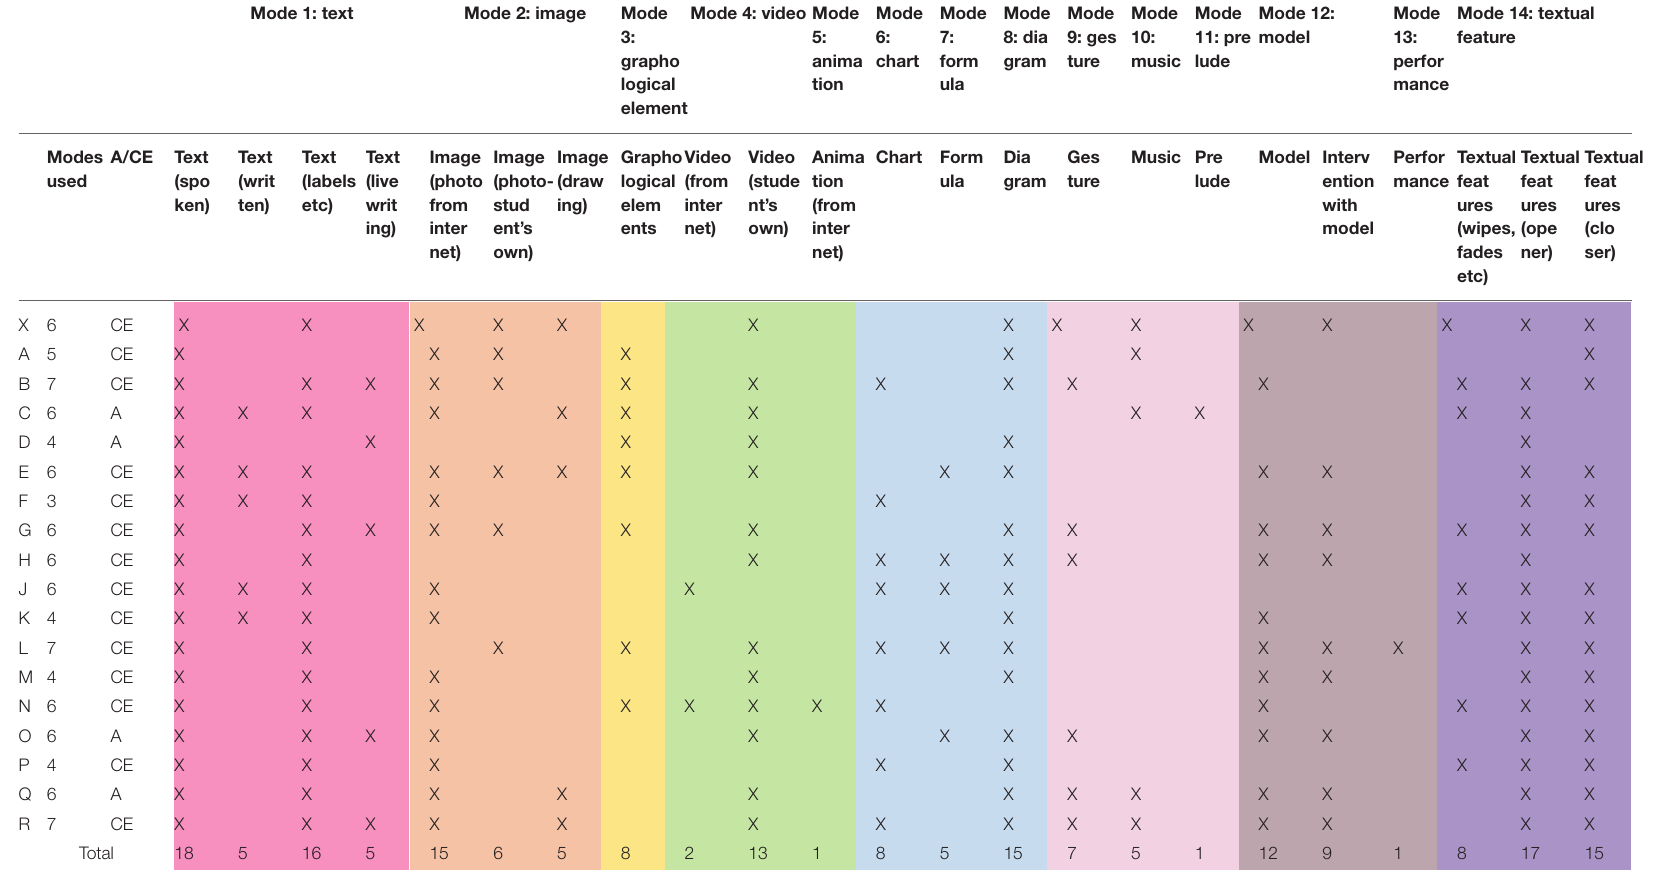
TABLE 1 | Table of modes